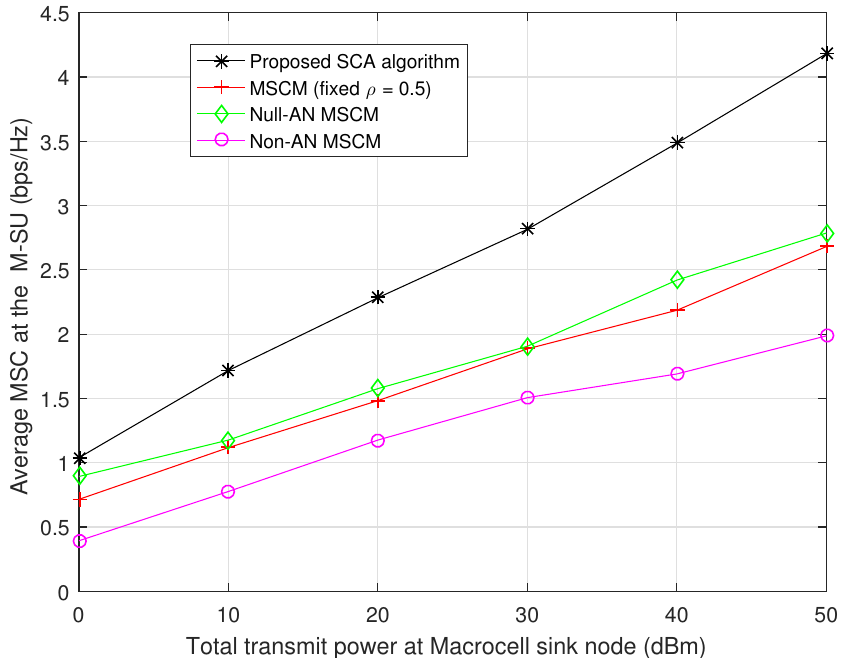
Figure 4. Average MSC at the M-SN with respect to the total transmit power at macrocell sink